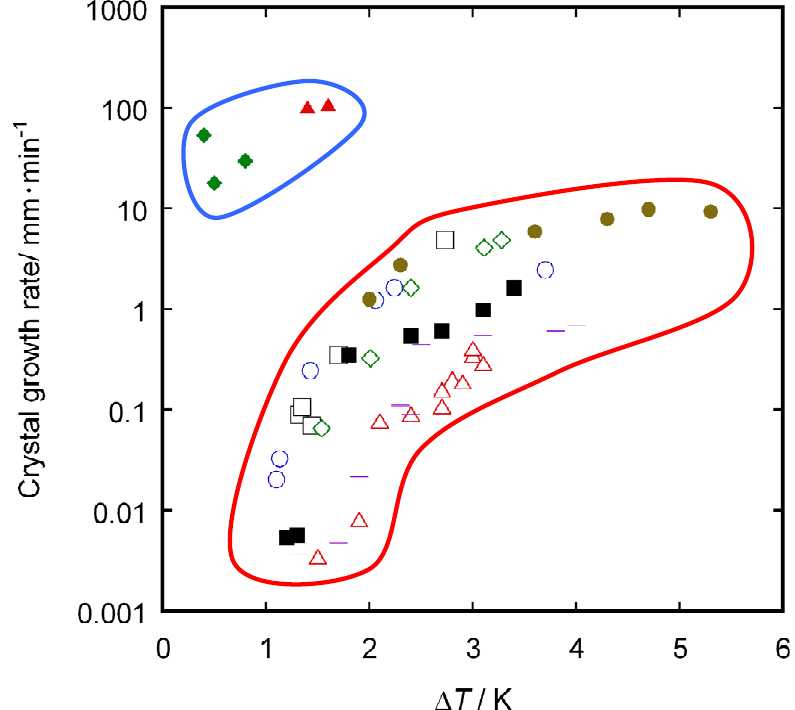
Figure 1. Dependence of hydrate-layer growth rate on the subcooling ∆ T for several reported studies: ( □ ) methane at 5.60 MPa [12]; ( ○ ) methane at 8.15 MPa [12]; ( ◇ ) methane at 10.56 MPa [12]; ( △ ) propane at 0.31 MPa [12]; ( － ) propane at 0.41 MPa [12]; ( ■ ) propane at 0.51 MPa [12]; ( ● ) methane [13]; ( ◆ ) CO 3 MPa [14]; ( ▲ ) CO (gas) at 5 MPa [14]. 2